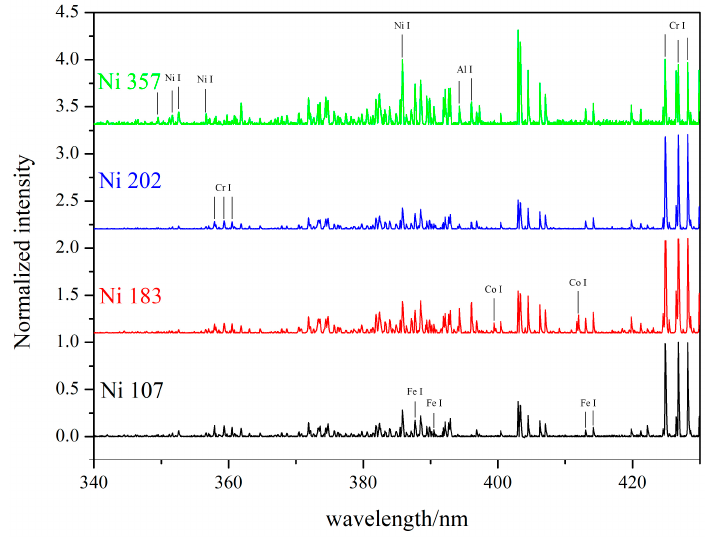
Figure 8. Spectra for four kinds of Ni-based laser cladding layers. (1600 W, 10 mm; the thickness is 0.8 mm).